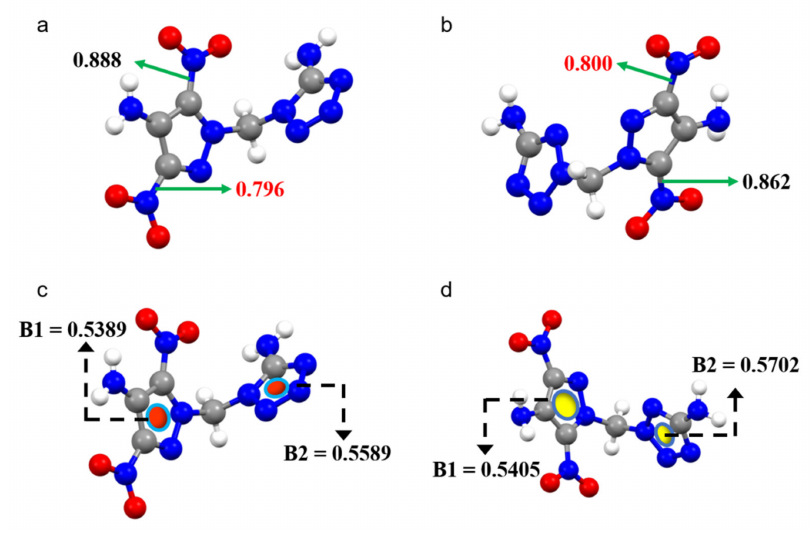
Figure 2. ( a , c ) Mayer bond order and the multicenter bond order analysis for DMPT-1; ( b , d ) Mayer bond order and the multicenter bond orders analysis for DMPT-2